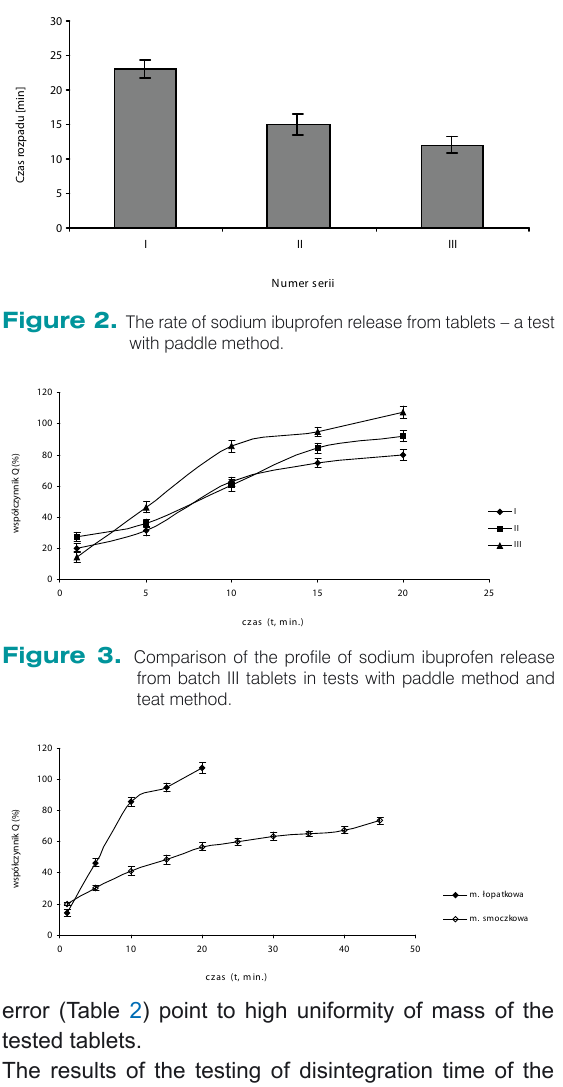
Figure 1. Disintegration time of the tested batches of tablets.